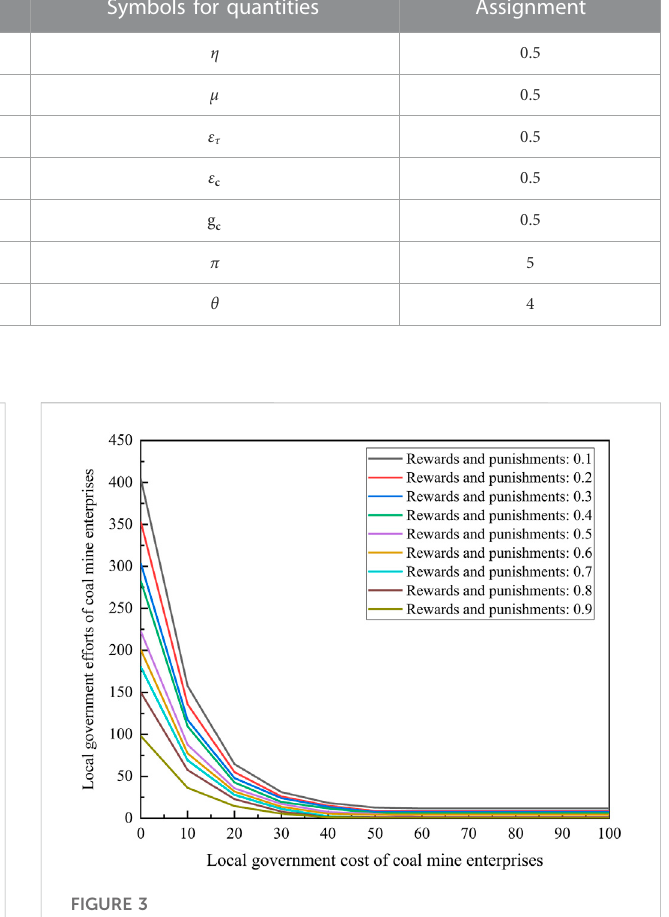
FIGURE 2 Relationship between emergency response efforts of coal mining enterprises and emergency response costs of local governments under the two scenarios.